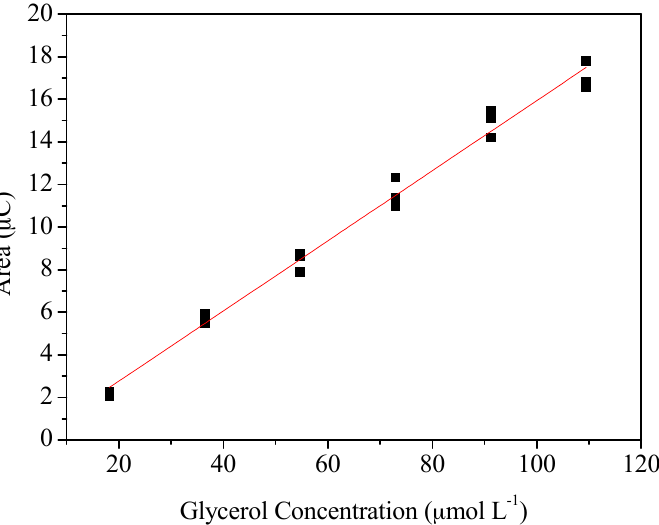
Figure 5. The analytical curve for glycerol in 0.030 mol L − 1 KOH (glycerol oxidation peak area versus glycerol concentration in triplicate) using the Au@Pd/rGO/GCE